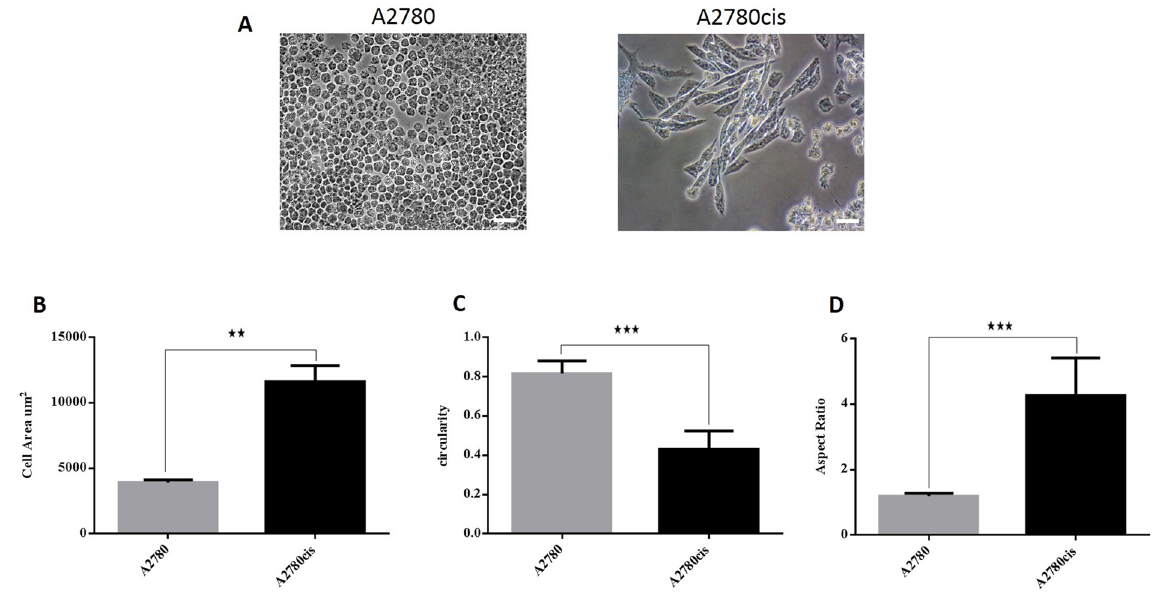
Figure 1. Cellular shapes of A2780cis and A2780 cells. ( A ) A2780 cells showed small round-shaped cells and A2780cis exhibit larger, more elongated shaped cells. Scale bar = 200 µm. ( B ) The mean cell area of A2780 and A2780cis cells shows that A2780cis cells have a larger area compared to A2780. ( C ) Cell circularity confirms that A2780 cells have a higher (mean) circularity value compared to A2780cis. ( D ) A2780cis have an aspect ratio above 4 while the round shape of A2780 is reflected by an aspect ratio ~ 1.